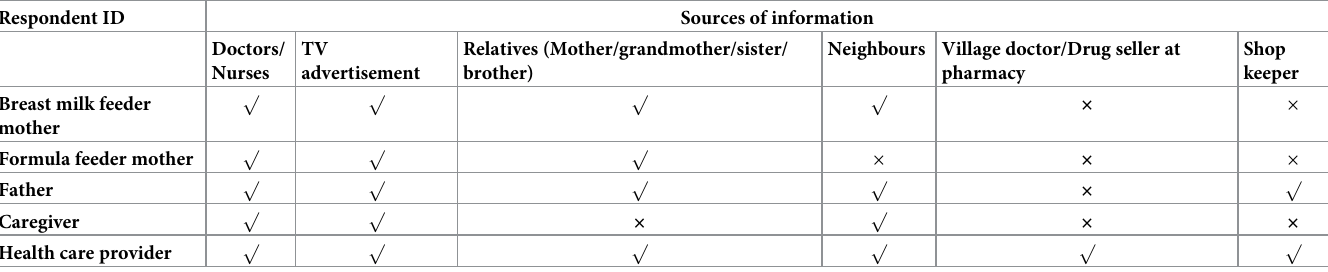
Table 3. Sources of information on infant formula.